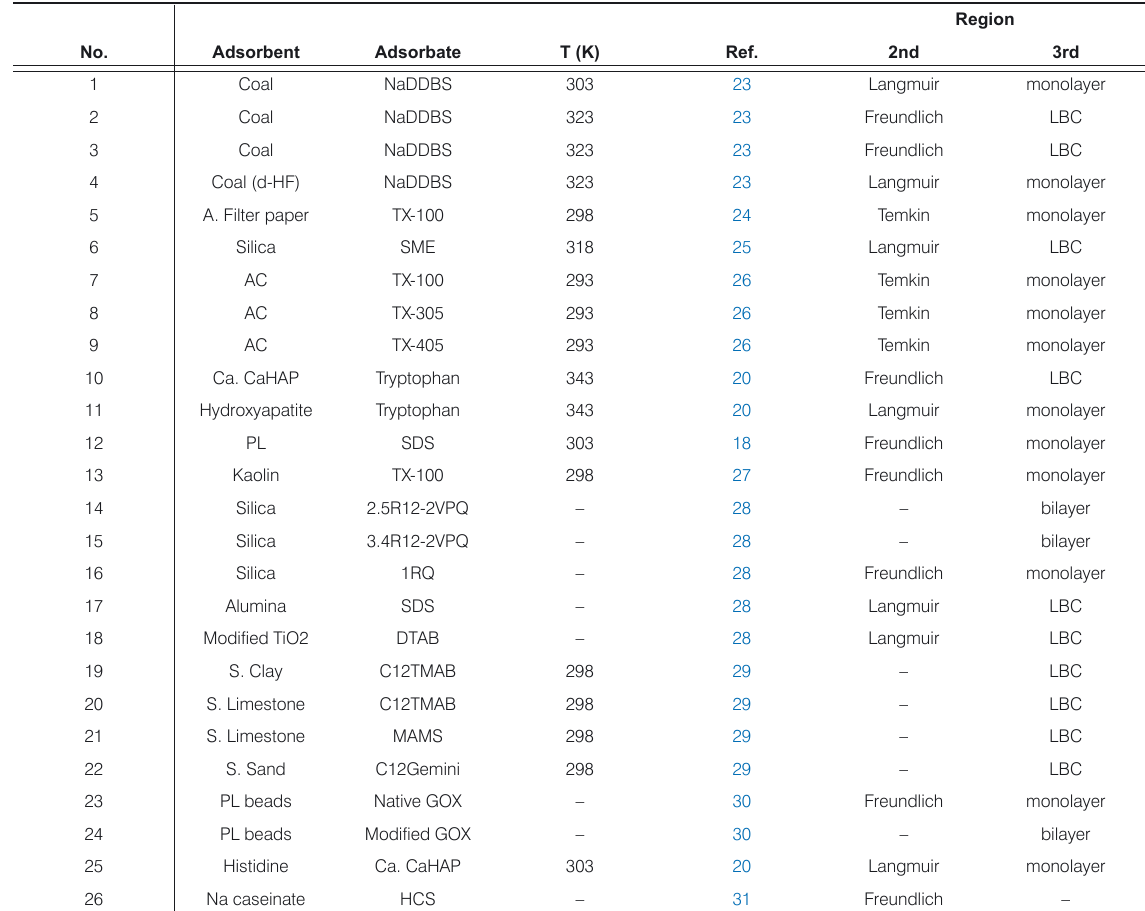
Table 1. Analysis of some literature adsorption isotherms by the ARIAN